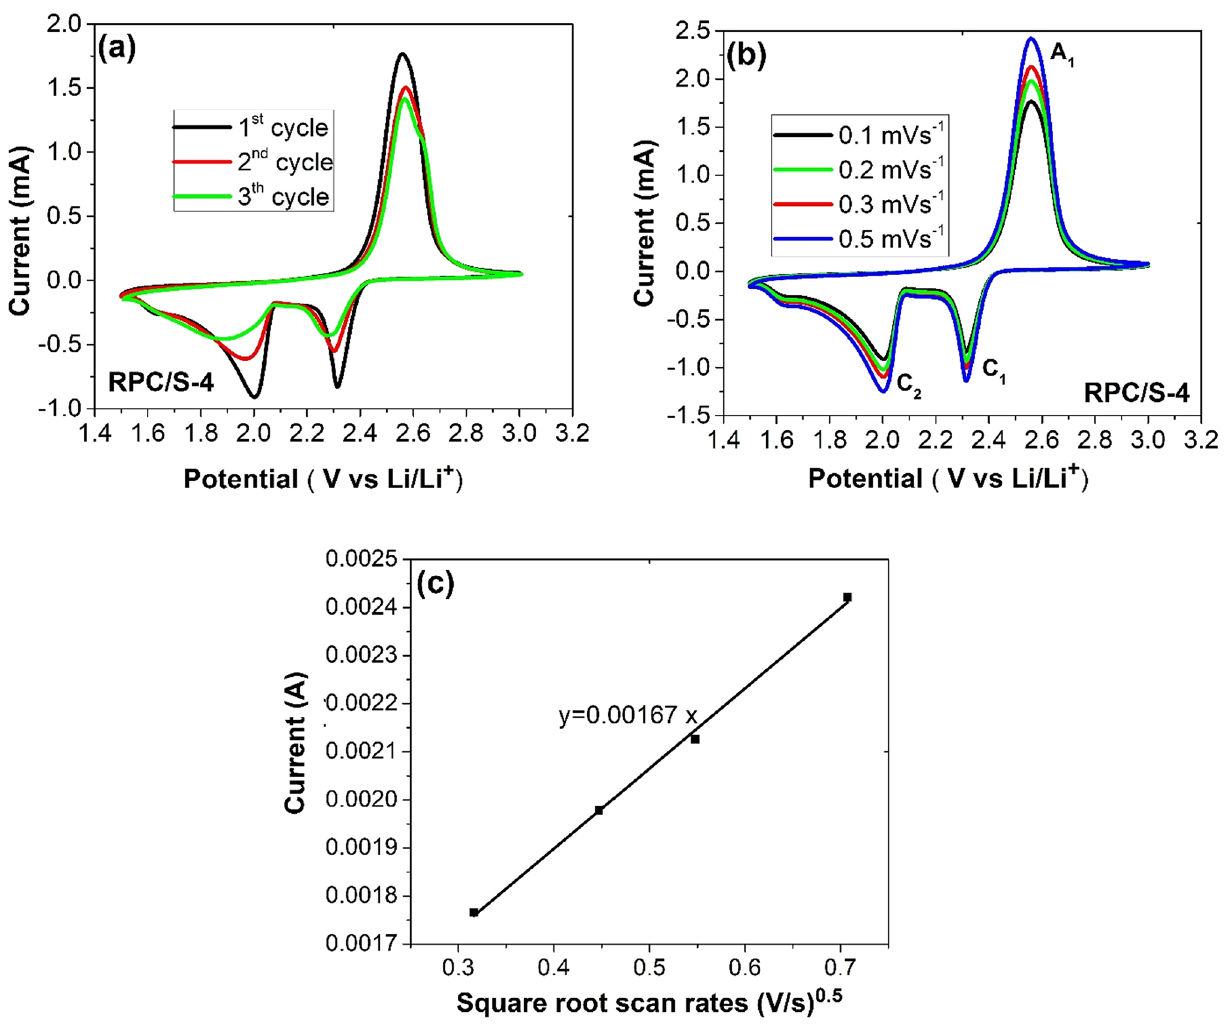
Fig. 7 a Cyclic Voltammetry (CV) profiles of RPC/S-4 in the first three cycles at scan rate of 0.1 mV s −1 , b CV of RPC/S-4 in the first cycle meas- ured at different scan rates, and c linear plotting of current vs square root scan